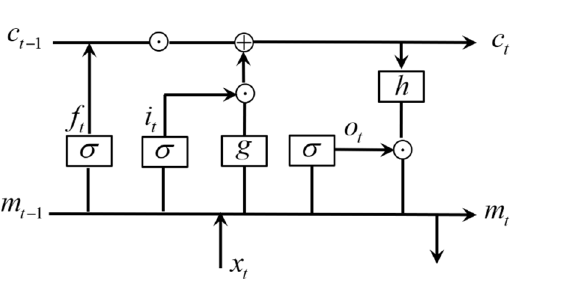
Figure 3. Architecture of LSTM memory cell.